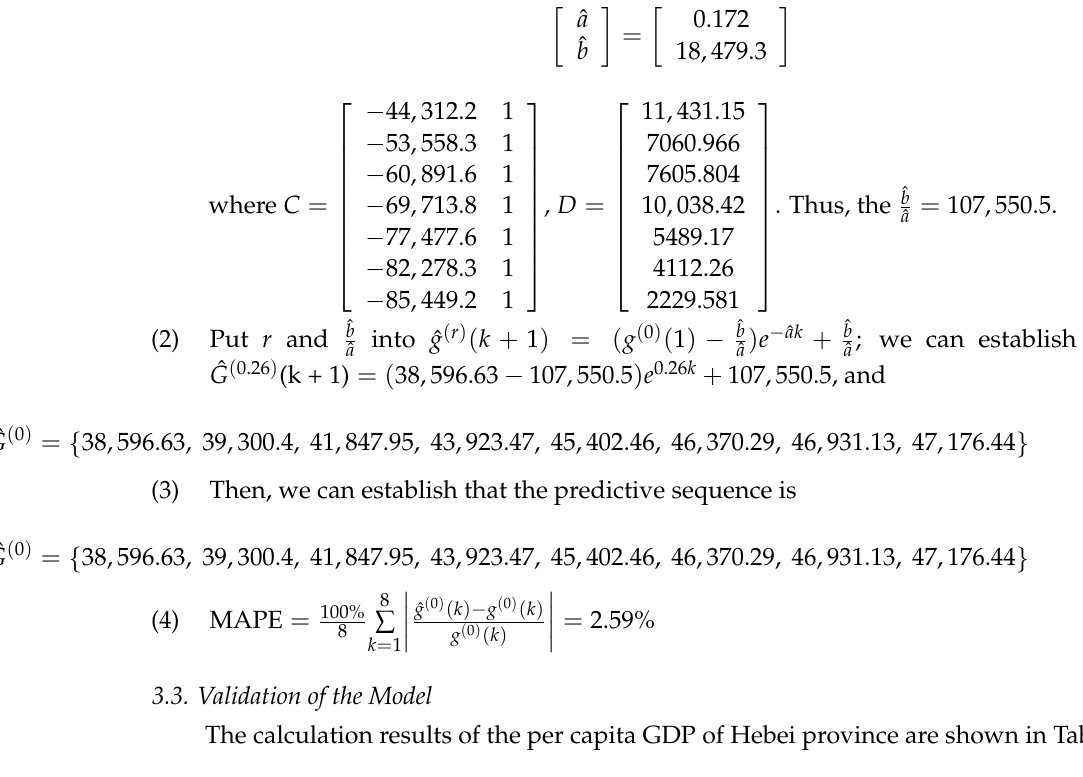
Table 1. Fitting results of per capita GDP in Hebei